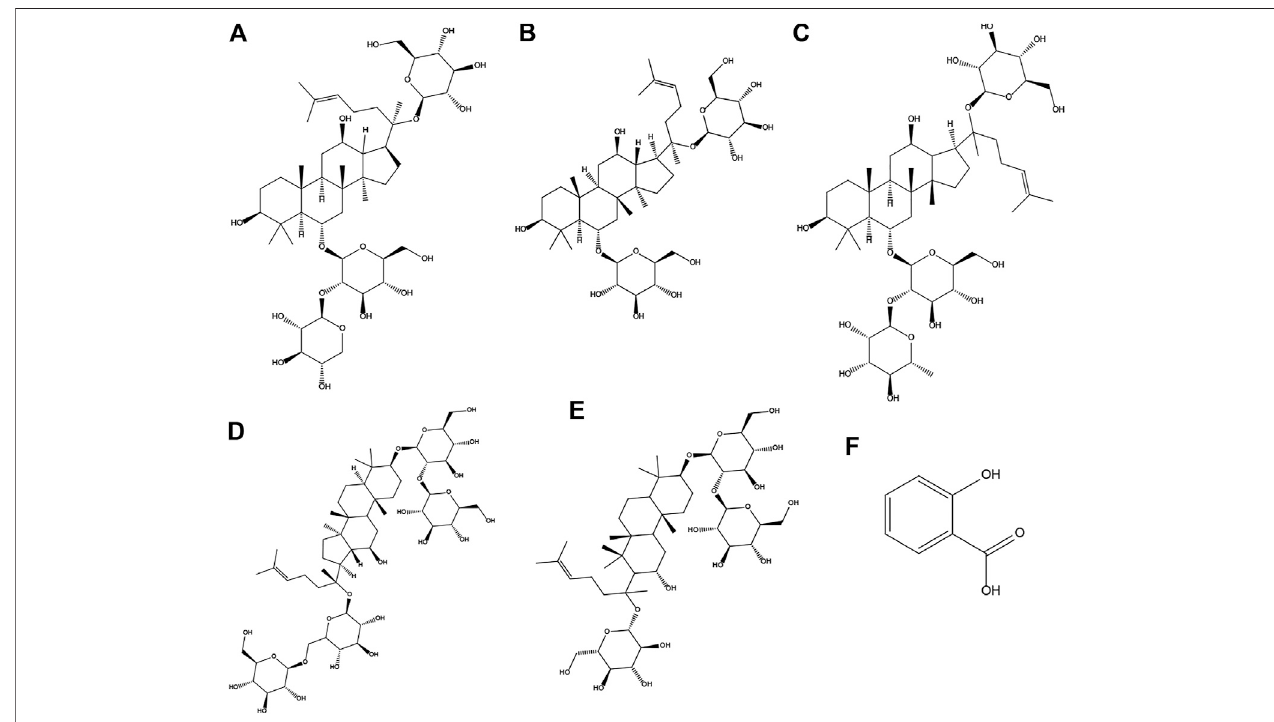
FIGURE 1 | Chemical structures of notoginsenoside R 1 (A) and ginsenoside Rg 1 (B) , Re (C) , Rb 1 (D) , Rd (E), and aspirin (F) .